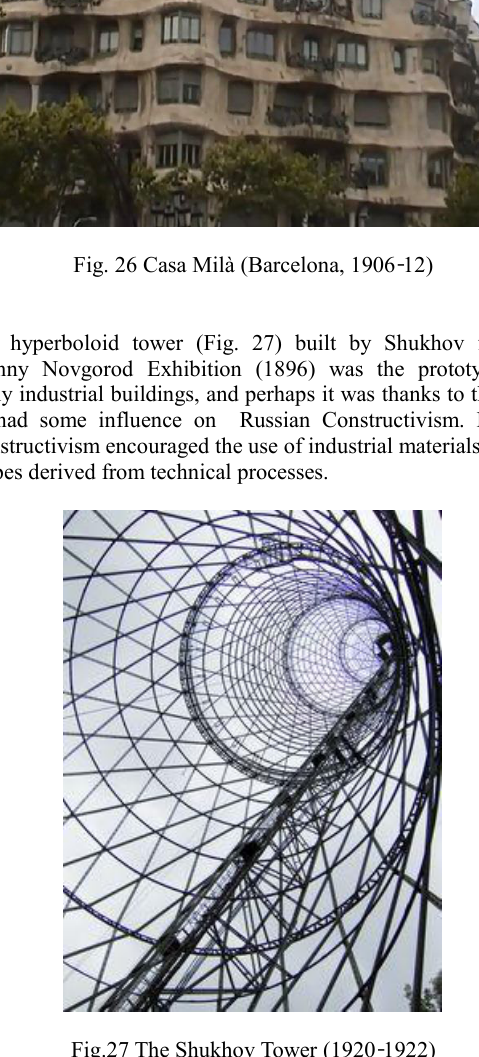
Fig.27 The Shukhov Tower